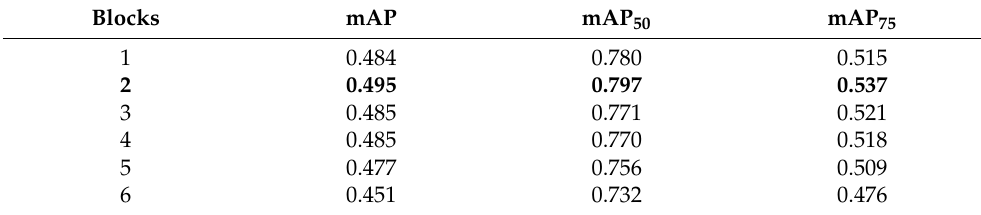
Table 1. Comparison of performance with varying number of Dynamic Head blocks.